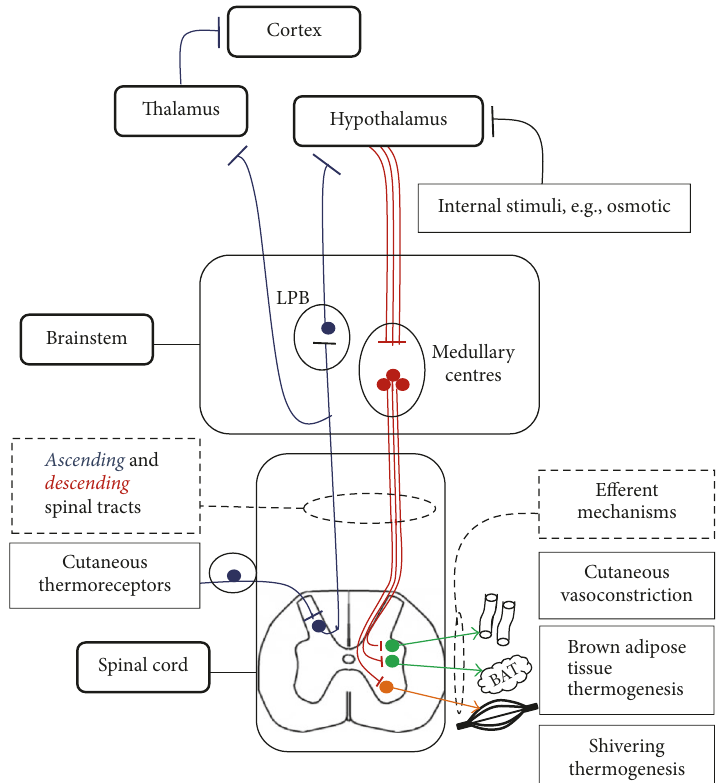
Figure 2: A schematic view of the main components of the thermoregulatory pathway according to the current main model [5, 6]. It is thought that cool and warm-sensitive cutaneous thermoreceptors detect changes in skin temperature. These are relayed via parallel ascending spinal cords tracts, to the pontine lateral parabrachial nucleus (LPB) [5]. In turn, the LPB transmits these to the anterior hypothalamus [5]. Afferent information is also separately sent to the cortex (thalamocortical tract) [5]. The hypothalamus integrates these signals with sensory information from other areas like visceral thermoreceptors and osmoreceptors to generate an effector response. In physiological conditions, after an increase in cutaneous cool signals is detected by the hypothalamic median preoptic subnucleus (MnPO) of the Preoptic Area (POA), disinhibition of the efferent pathways (in red color) leads to the activation of the three main heat-maintenance/producing mechanisms [5]. The rostral ventromedial medulla, including the rostral raphe pallidus nucleus (rRPa), is considered a key supraspinal area which regulates cutaneous vasoconstriction (CVC) and brown adipose tissue (BAT) thermogenesis (sympathetic (in green color)) and shivering thermogenesis (somatic (in orange color)) [5,